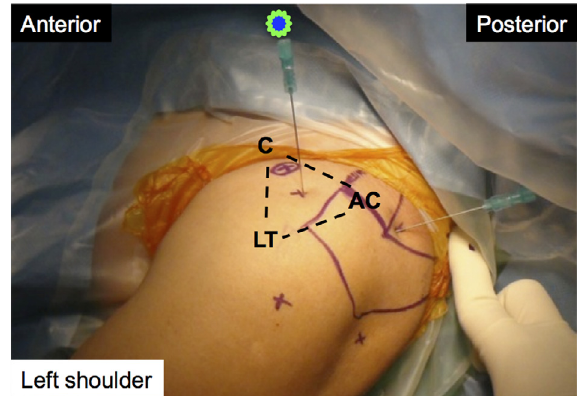
Figure 2. Superomedial technique. A: acromion; DC: distal clavicle.